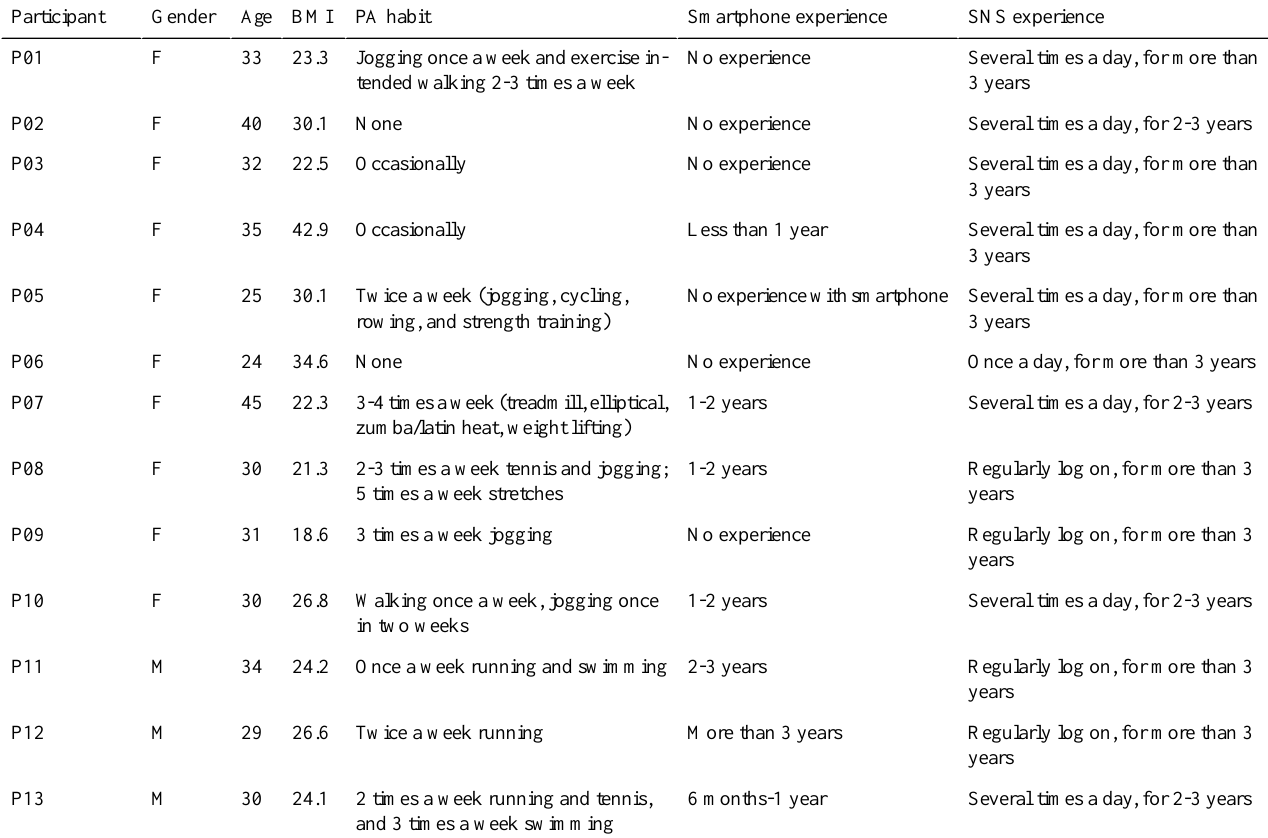
Table 3. General demographic, PA habit, smartphone experience, and SNS